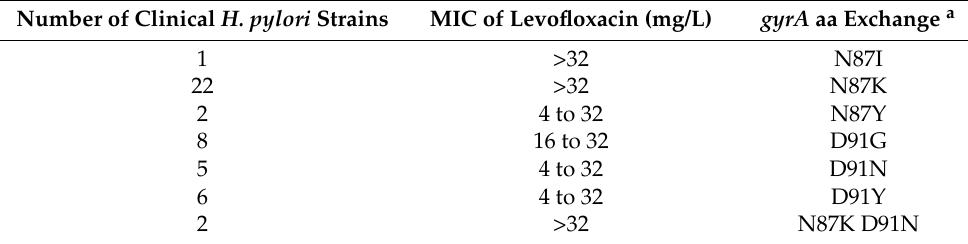
Table 3. Amino acid exchanges identified by WGS in the QRDR of the gyrA gene at codon 87 and/or 91 in 46 levofloxacin resistant H. pylori isolates and their corresponding MICs. Number of Clinical H. pylori Strains MIC of Levofloxacin (mg/L) gyrA aa Exchange a 1 >32 N87I 22 >32 N87K 2 4 to 32 N87Y 8 16 to 32 D91G 5 4 to 32 D91N 6 4 to 32 D91Y 2 >32 N87K